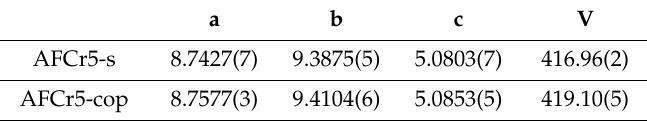
Table 1. Unit cell parameters for AFCr5-s and AFCr5-cop.